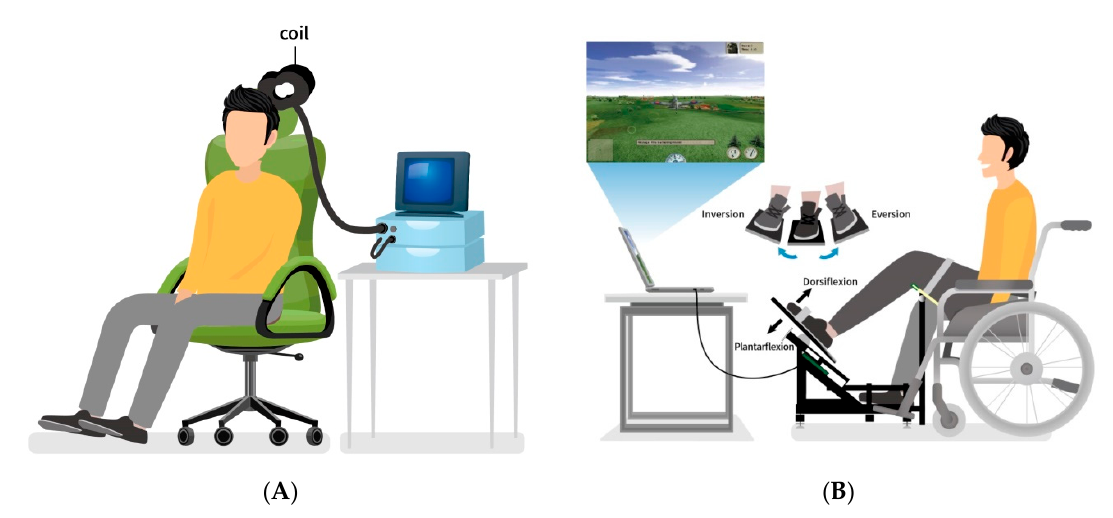
Figure 2. Study design.